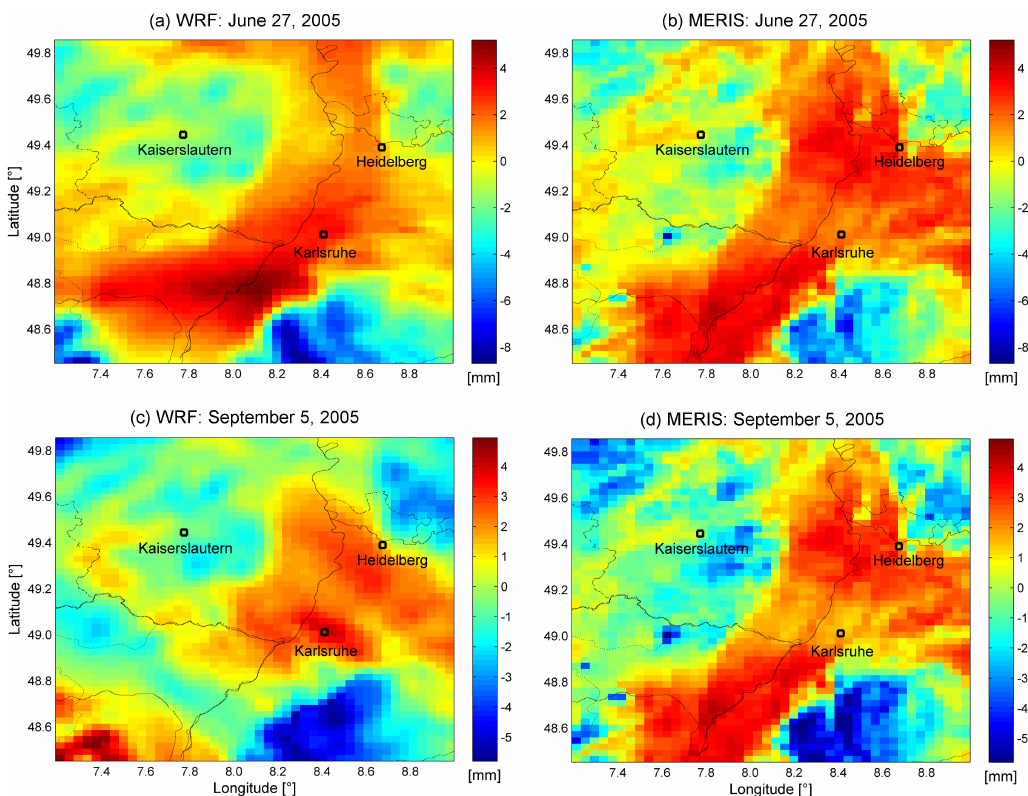
Figure 3. Maps of PWV content as received from MERIS and WRF, where a linear trend is subtracted from each map. The upper data are received on 27 June 2005 (09:51UTC), the lower data on 5 September 2005 (09:51UTC). Gaussian averaging is applied to scale the MERIS data at WRF resolution, 3km × 3km. The spatial correlation coefficient between the upper maps is 0.8 and 0.71 for the lower maps.